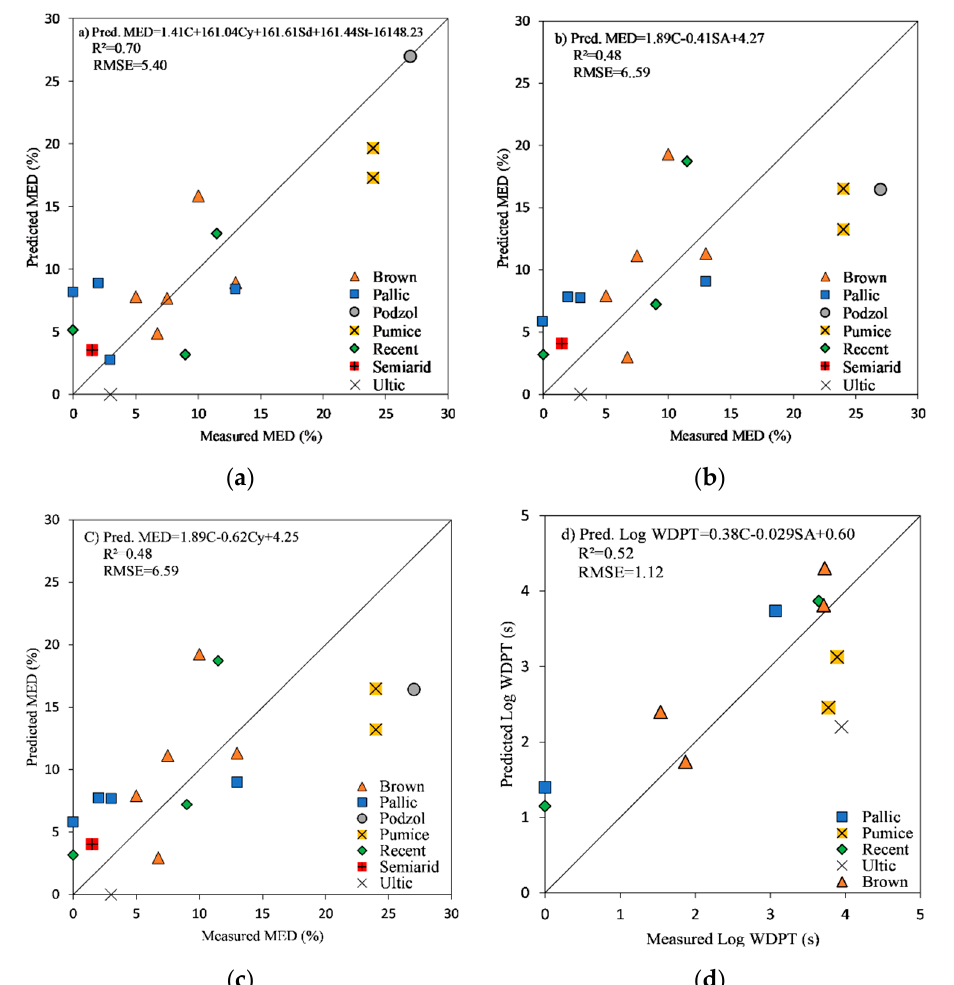
Figure 2. Multiple linear regressions (MLR) for the molarity of ethanol drop (MED) using ( a ) carbon and soil particles size distribution; ( b ) carbon and surface area (SA); ( c ) carbon and clay (Cy); and ( d ) the MLR for Log WDPT using C and